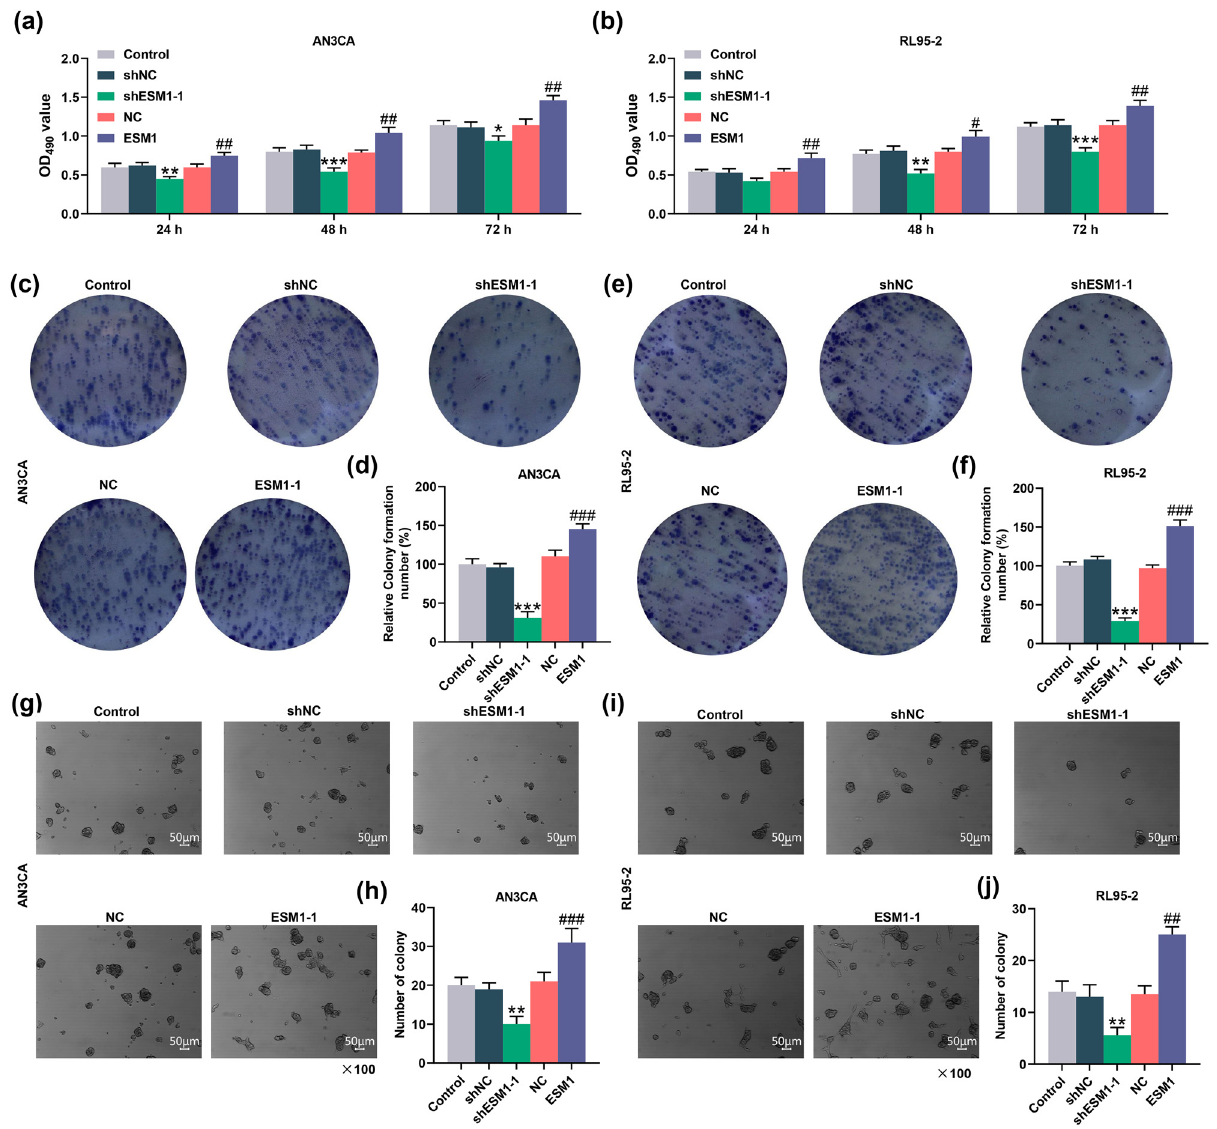
Figure 3: ESM1 overexpression promoted the viability and proliferation of EC cells, while silencing of ESM1 had opposite e ff ects. ( a and b ) 24, 48, and 72 h after cell transfection with shESM1 - 1 or ESM1 overexpression plasmids, ESM1 overexpression markedly promoted the viability of AN3CA and RL95 - 2 cells, while sh - ESM1 worked conversely, as measured by MTT assay. ( c – f ) Colony formation assay was employed to evaluate the e ff ect of ESM1 silencing or its overexpression on the colony - forming abilities of AN3CA and RL95 - 2 cells. The representative image was presented and relative colony formation was detected. ( g – j ) After transfection with silencing or overexpression plasmid of ESM1 in AN3CA and RL95 - 2 cells, cell anchorage - independent assay was conducted to detect the cell anchorage - independent proliferation potential. * P < 0.05, ** P < 0.01, *** P < 0.001 vs short hairpin RNA - targeted negative control ( shNC ) ; # P < 0.05, ## P < 0.01, ### P < 0.001 vs